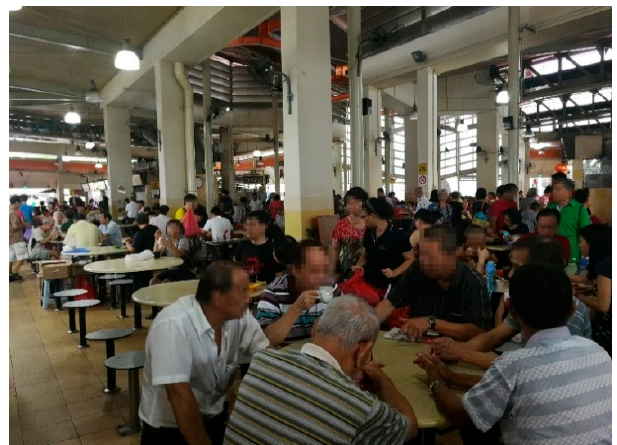
Figure 12. Yuhua Village Hawker Centre where people eat, drink coffee and meet friends.